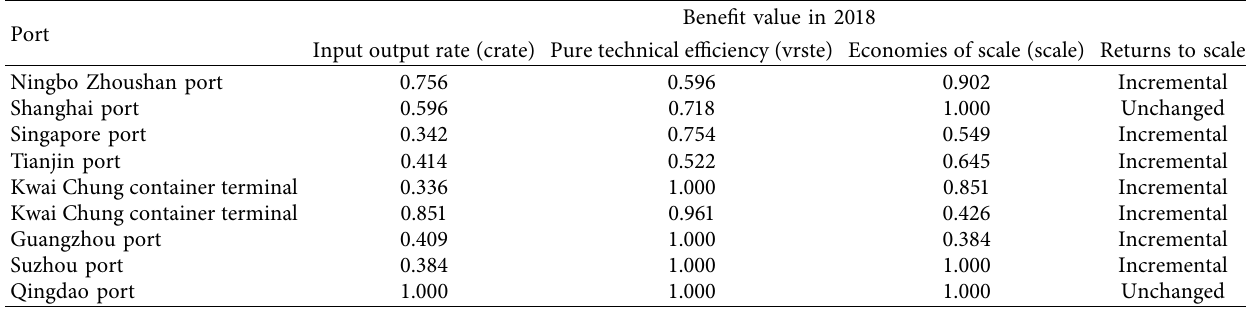
Table 6: Input-output efficiency levels of nine ports in 2018.